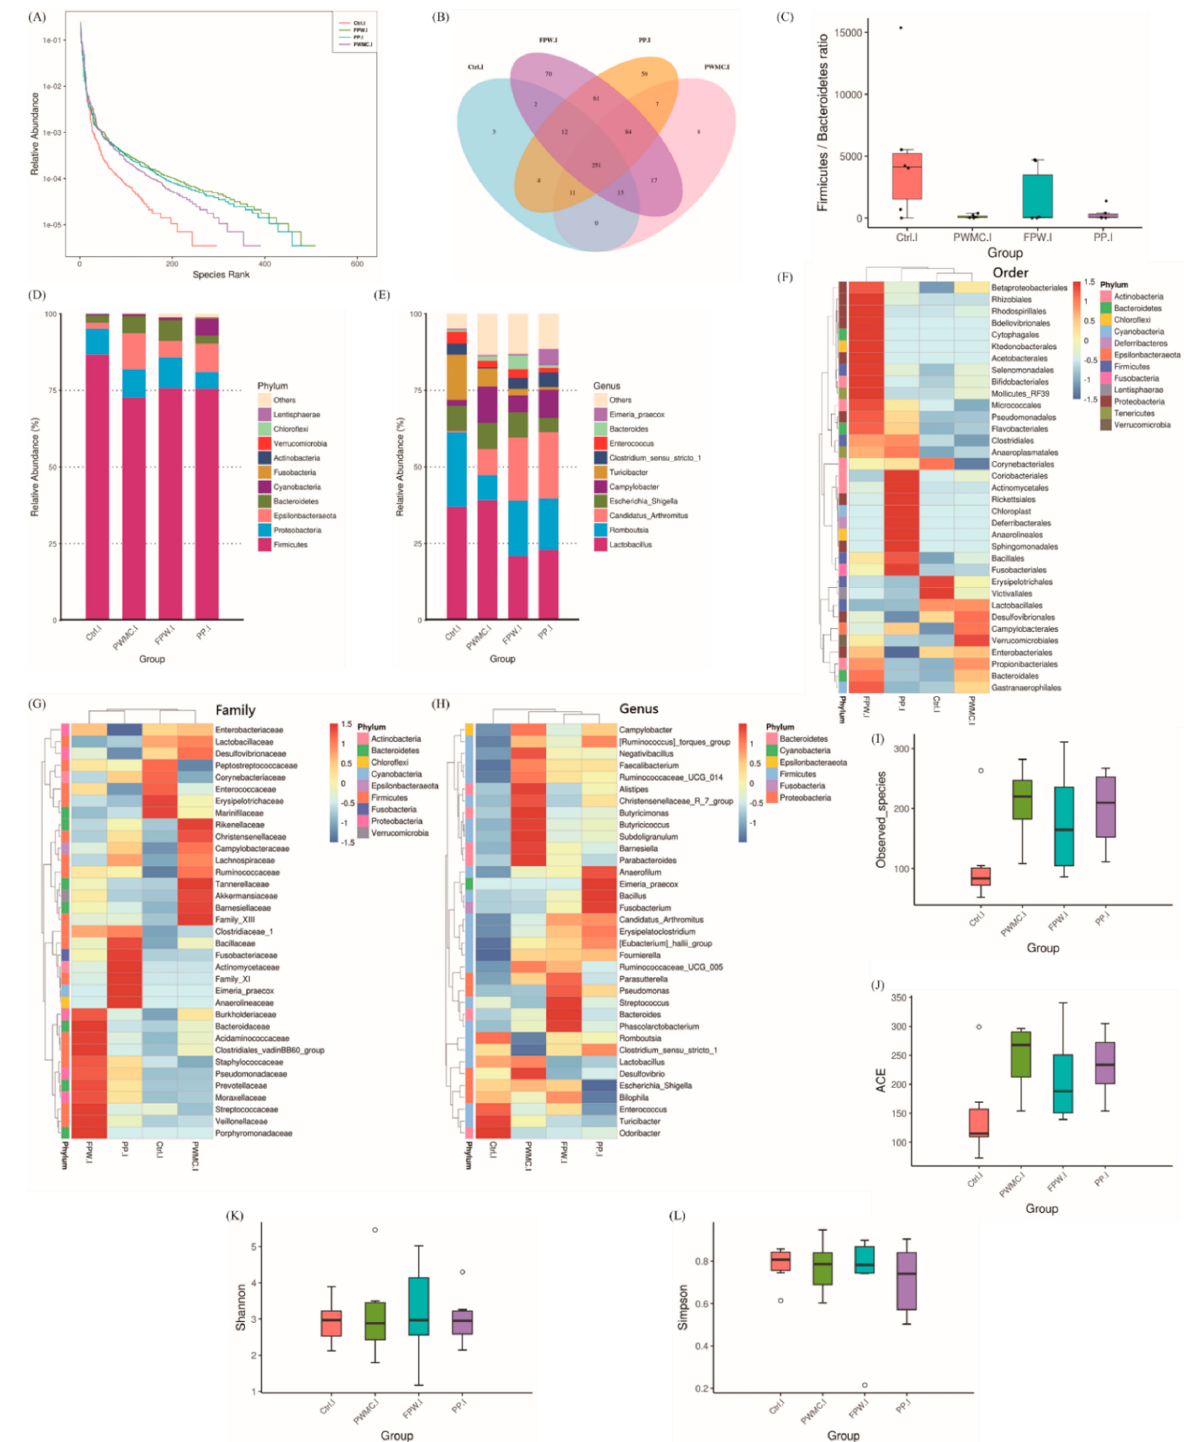
Figure 2. The 35–day–old broilers’ ileum microbiota influenced by a corn–soybean basal diet (Ctrl), Pennisetum purpureum Schum No. 2 waste mushroom compost (PWMC), Saccharomyces cerevisiae fermented PWMC (FPW), and Pennisetum purpureum Schum No. 2 (PP). ( A ) Microbe relative abundance; ( B ) Microbe Venn diagram; ( C ) Firmicutes to Bacteroidetes ratio; ( D , E ) Relative abundance of each microbe in the broilers’ ileum at the phylum ( D ) or genus ( E ) level; ( F – H ) Taxa heatmap of ileum microbes according to order ( F ), family ( G ), and genus ( H ). ( I – L ) Alpha diversity of 35–day–old broilers’ ileum microbes in each treatment; ( I ) Observed species, ( J ) Abundance-based coverage estimator (ACE), ( K ) Shannon index, and ( L ) Simpson index. Results are means of six samples obtained from the individual birds from the control and experimental groups ( p <